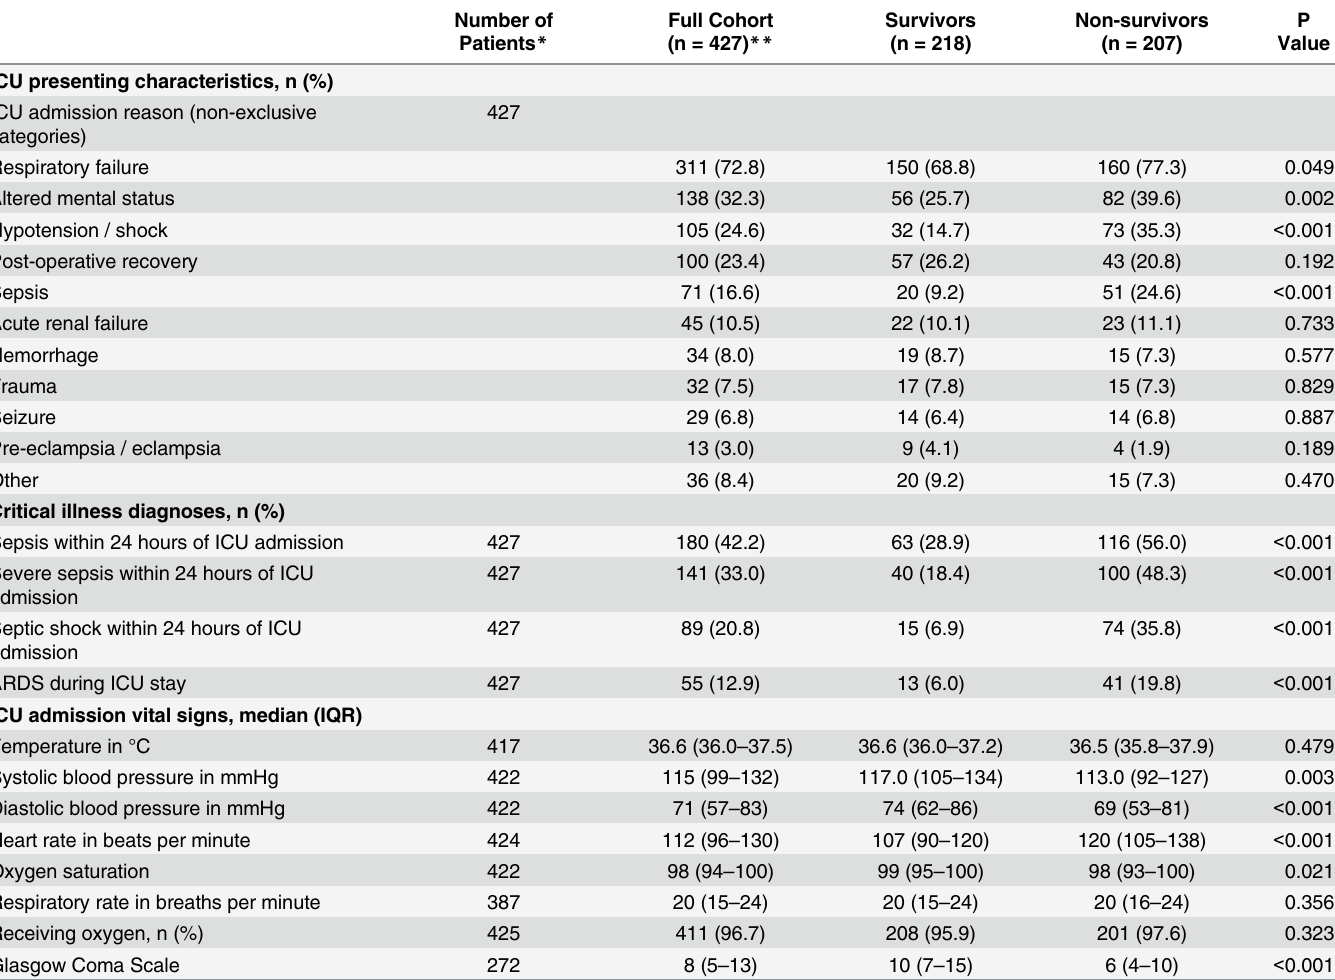
Table 2. Patient characteristics at ICU admission and during ICU